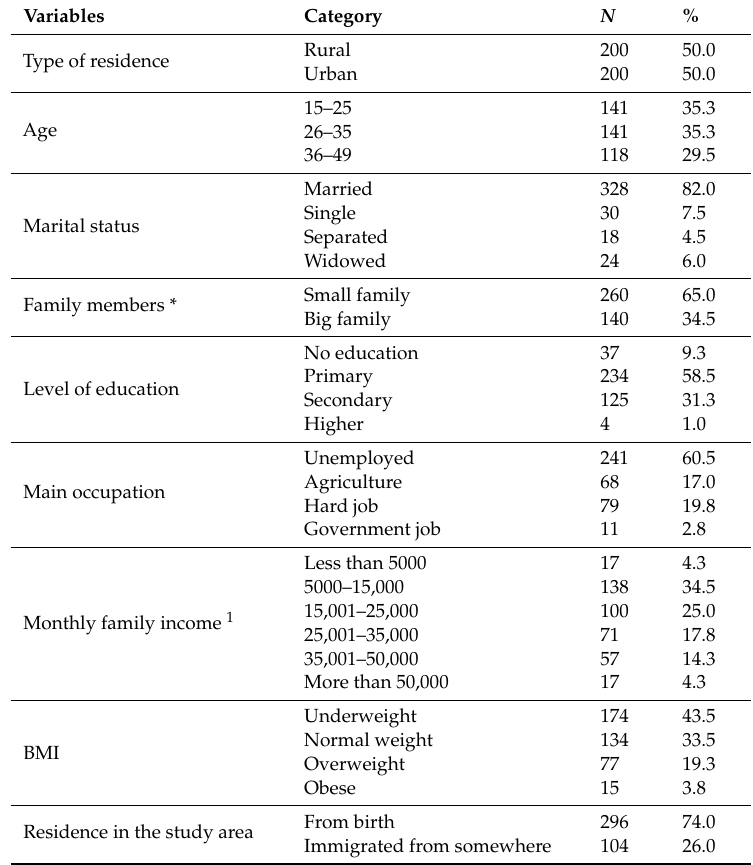
Table 2. Demographic characteristics of reproductive-age women ( N =